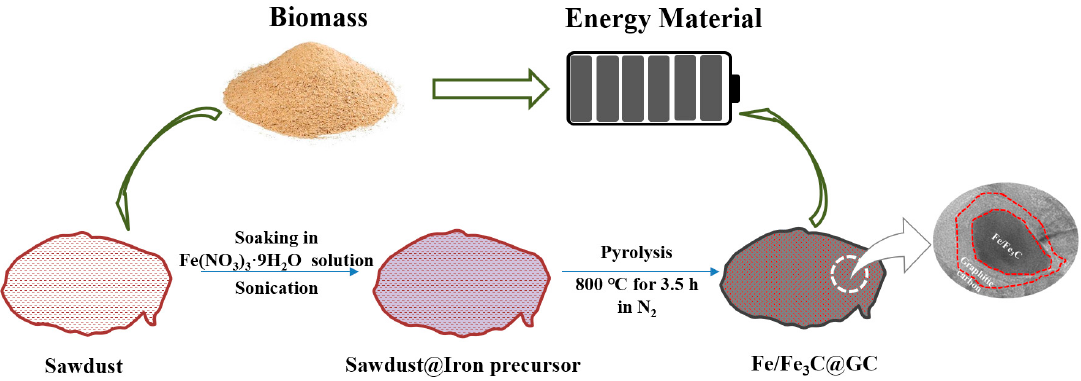
Figure 1. Illustration of the sequential fabrication steps for Fe/Fe 3 C@GC composite.